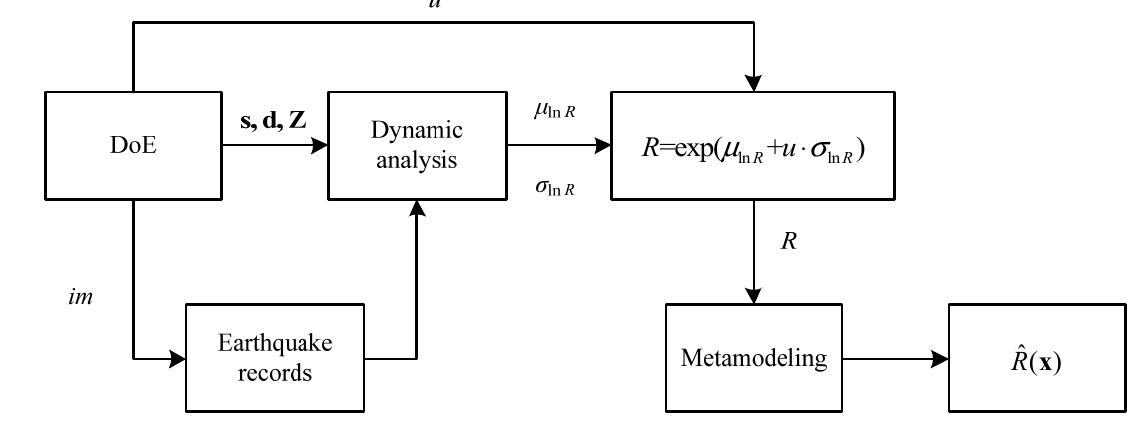
Figure 1. Schematic of metamodeling for EDP.